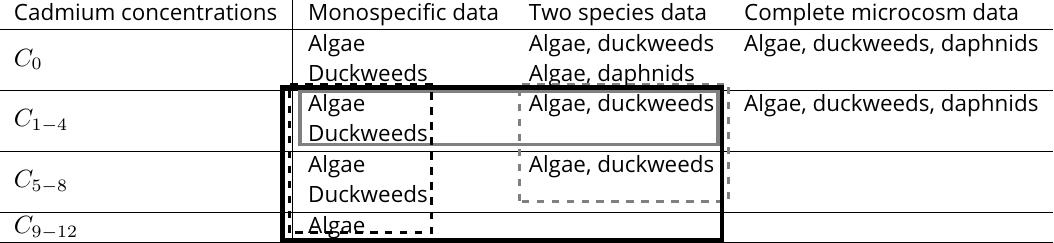
Table 2. Experimental design and partial